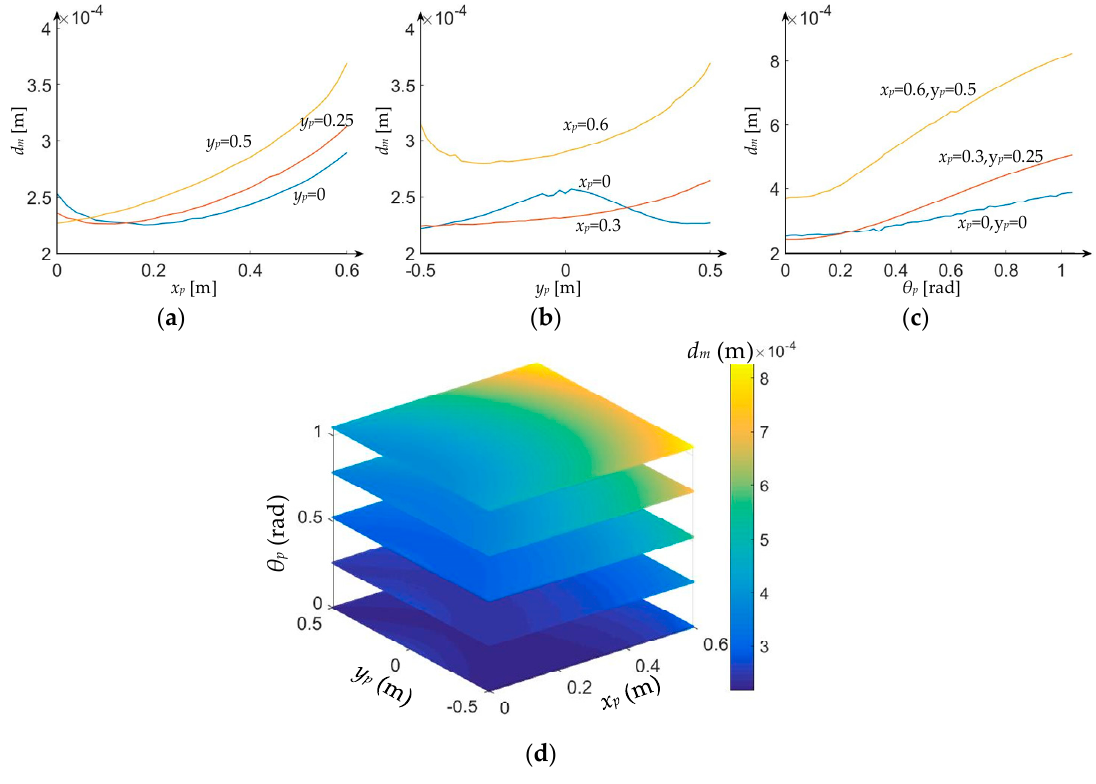
Figure 7. d m with the different workpiece poses p : ( a ) The curves of d m change with x p when θ p = 0 and y p = 0 m, 0.25 m, and 0.5 m; ( b ) the curves of d m change with y p when θ p = 0 and x p = 0 m, 0.3 m, and 0.6 m; and ( c ) the curves of d m change θ p when [ x p , y p ] = [0,0] m, [0.3, 0.25] m, and [0.6, 0.5] m. ( d ) The variation of d m in the x p y p plane when θ p is equal to 0, π /12 rad, π /6 rad, and π /3 rad.